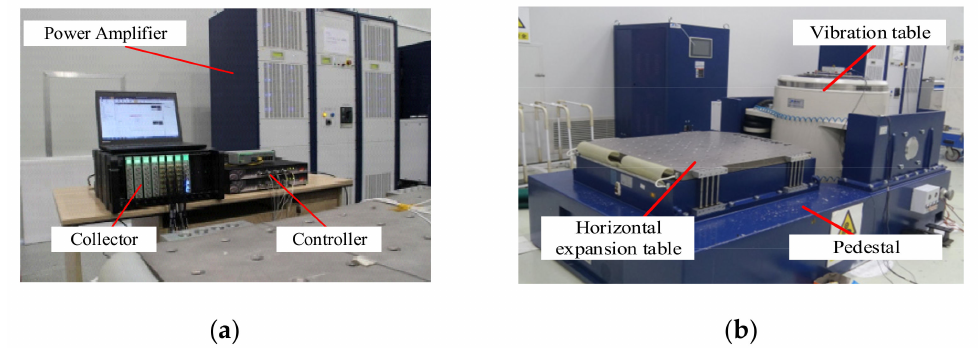
Figure 17. Main equipment required for vibration test. ( a ) Vibration signal acquisition and control equipment. ( b ) Part of the shaker equipment.